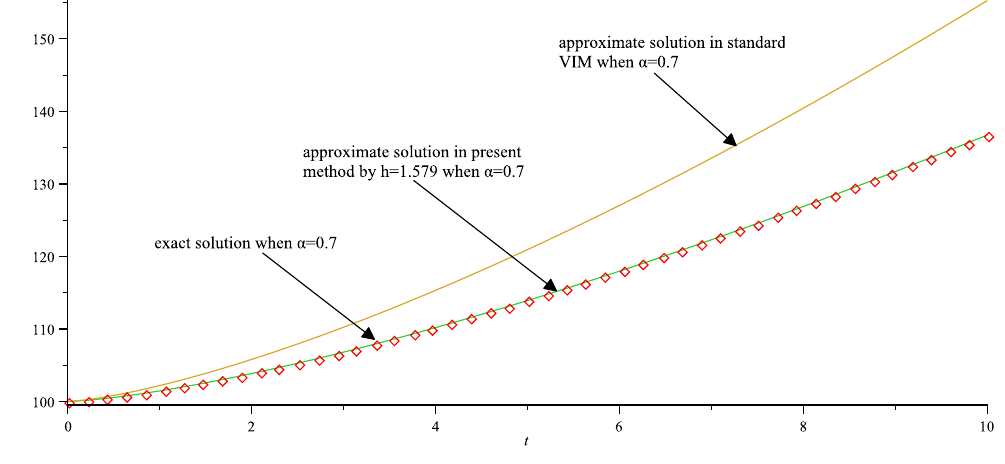
Figure 6. Plots of third-order approximation solutions by present method and standard VIM at x = 10 for α = 0.7 in Example